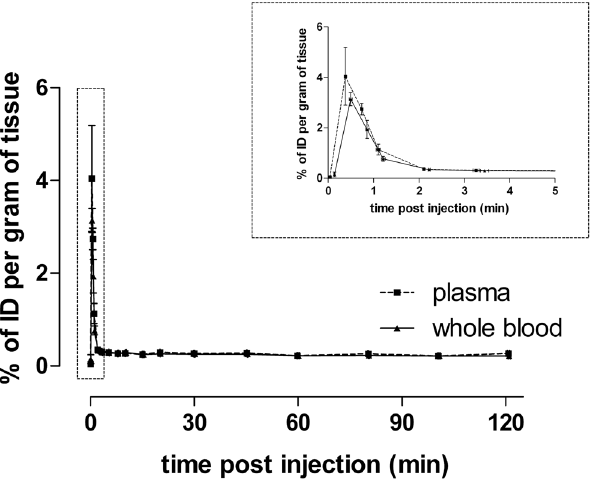
Fig. 5. Percentage of injected [ 125 I]WYE-230949 in plasma and whole blood of anaesthetised rats measured ex vivo. Data are from three animals at 5, 10, 20, 60 and 100 min, six animals at 0, 0.33, 0.66, 1, 2, 3, 7.5, 15, 45, 80 and 120 min and nine animals at 30 min following intravenous injection of [ 125 I]WYE- 230949. Inset showing the update during the first 5 min following injection.